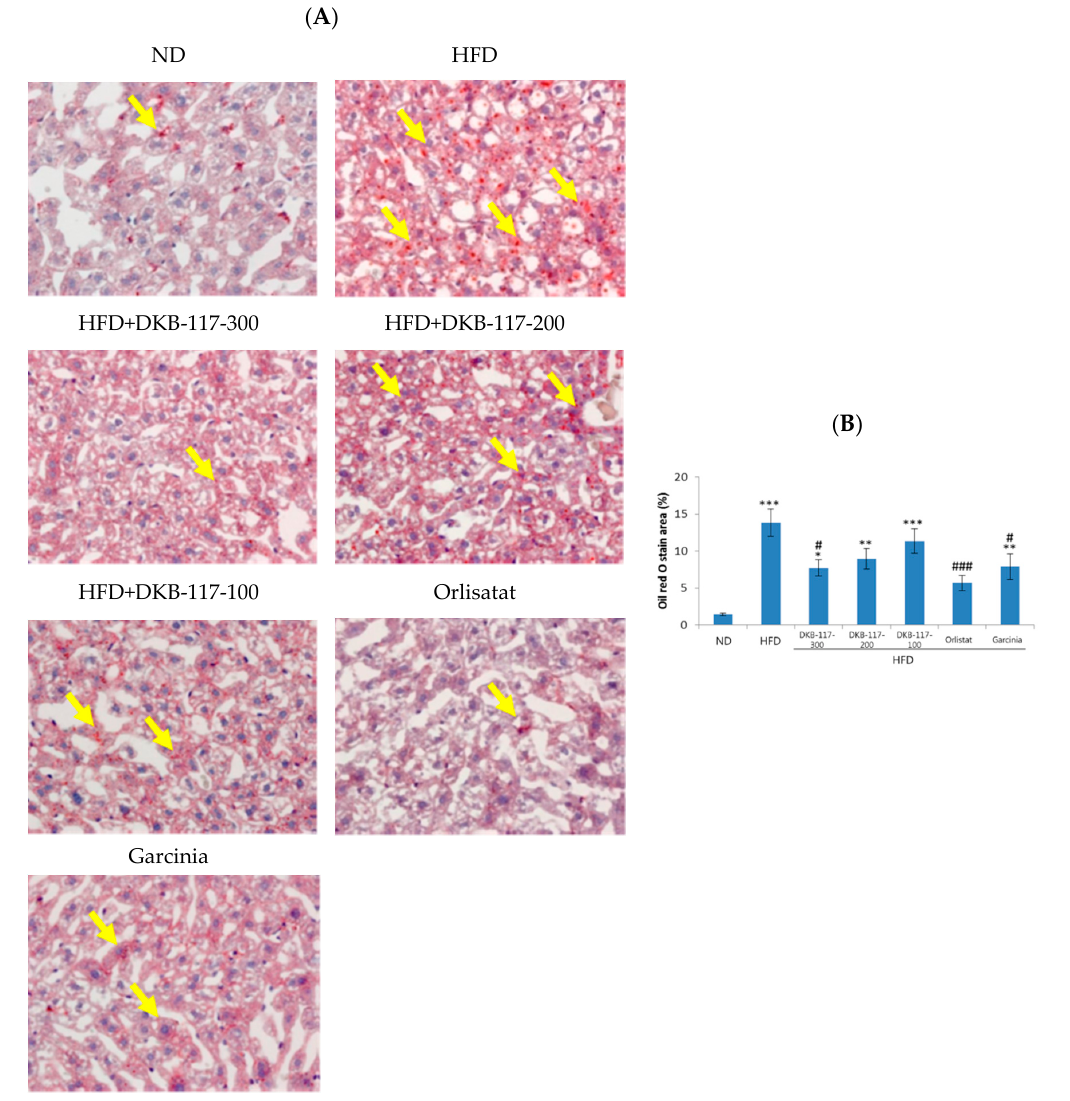
Figure 4. Effect of DKB-117 extracts on lipid accumulation in HFD-induced obese mice. ( A ) The Oil-Red-O staining in liver sections (×400, magnification) and ( B ) quantification of the positively stained area. The values are presented as means ± SEMs. ***/**/* A significant difference at the p < 0.001/ p <0.01/ p <0.05 level compared to the ND. ###/# A significant difference at the p < 0.001/ p < 0.05 level versus the HFD. ND, normal diet control group; HFD, high-fat diet control group; DKB-117-300, DKB-117 300 mg/kg; DKB-117-200, DKB-117 200 mg/kg; DKB-117-100, DKB-117 100 mg/kg; Orlistat, orlistat 40 mg/kg; Garcinia, Garcinia cambogia 200 mg/kg.